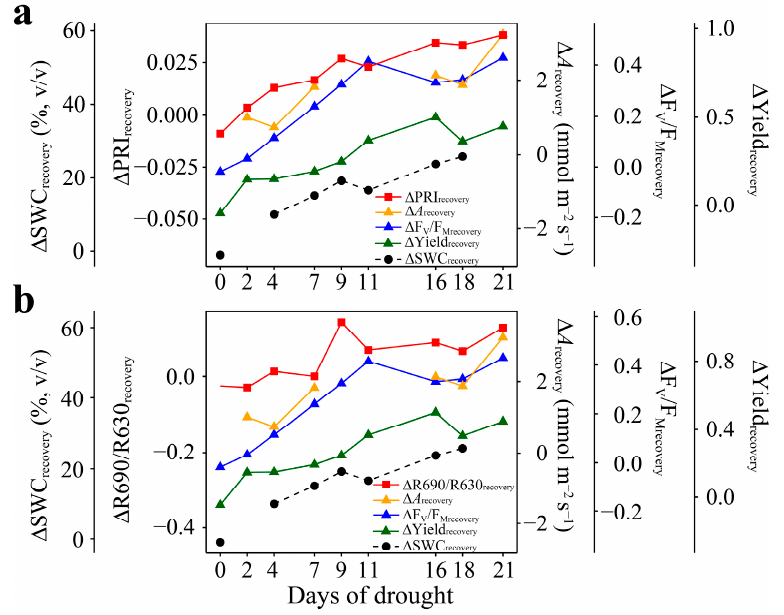
Figure 4. Changes in differential A ( Δ A ), Δ F V /F M , Δ Yield, and Δ SWC with Δ PRI ( a ) and with Δ R690/R630 ( b ) in response to nine different drought levels for Quercus ilex . The differential values of variables calculated by subtracting the mean of nine drought levels treatment from corresponding mean of recovery treatments in Figure